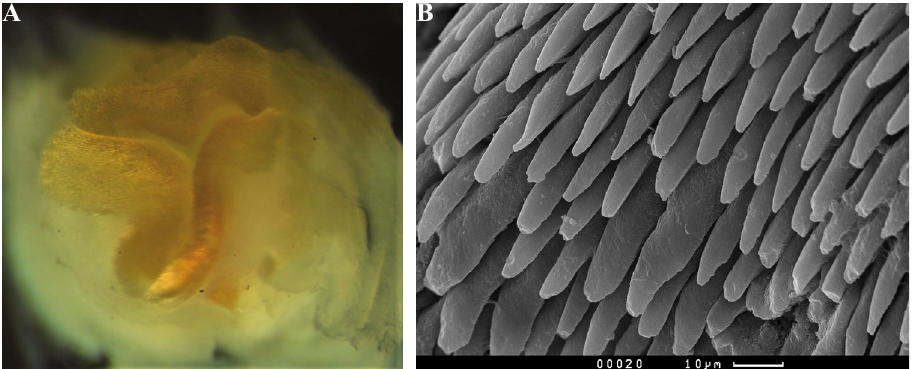
Figure 10. Paradoris hypocrita sp. nov., jaws of paratype SMF 360588 A light micrograph of three plates B SEM of